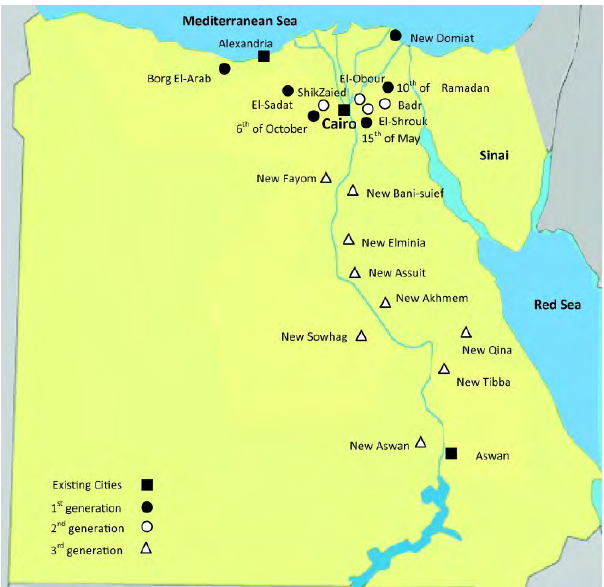
Figure 9. Egypt Map Shows Important Cities